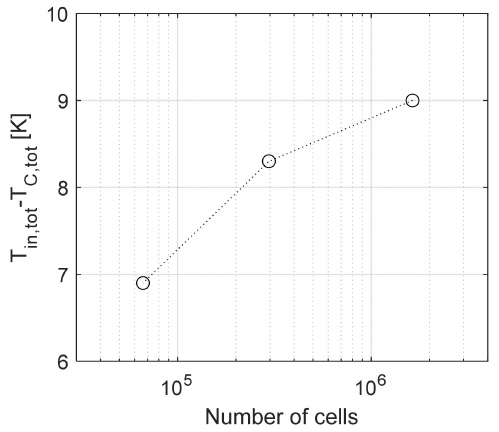
Figure 4. Total temperature drop at the cold outlet obtained on three grids.